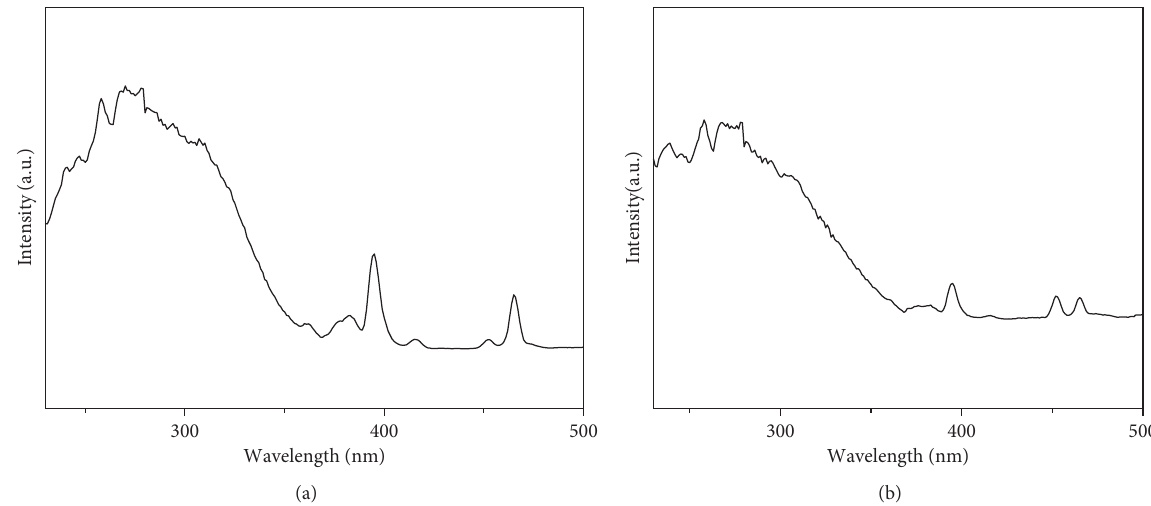
Figure 8: Excitation spectrum of YVO 3+ obtained under emission of 618 nm at room temperature through (a) hydrothermal 4 :(5%) Eu method with pH � 11 and (b) sonication method with pH